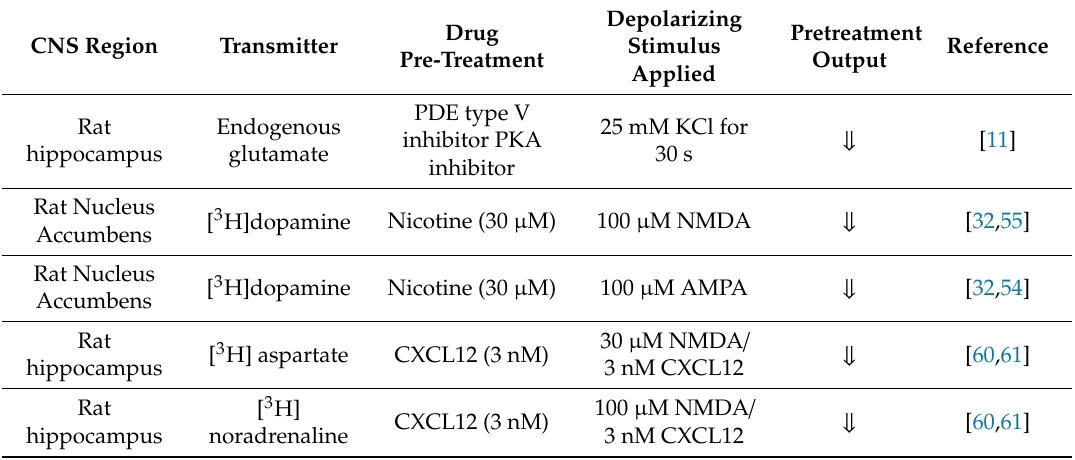
Table 1. In vitro” persistent “presynaptic adaptation” in